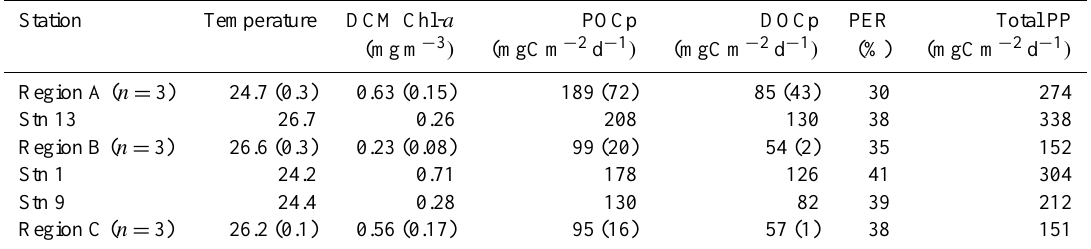
Table 1. Mean values of surface temperature ( ◦ C), chlorophyll a concentration (Chl- a ) at the deep chlorophyll maximum (DCM), vertically integrated particulate (POCp) and dissolved primary production (DOCp), the percentage of extracellular release (PER), and total integrated primary production rates